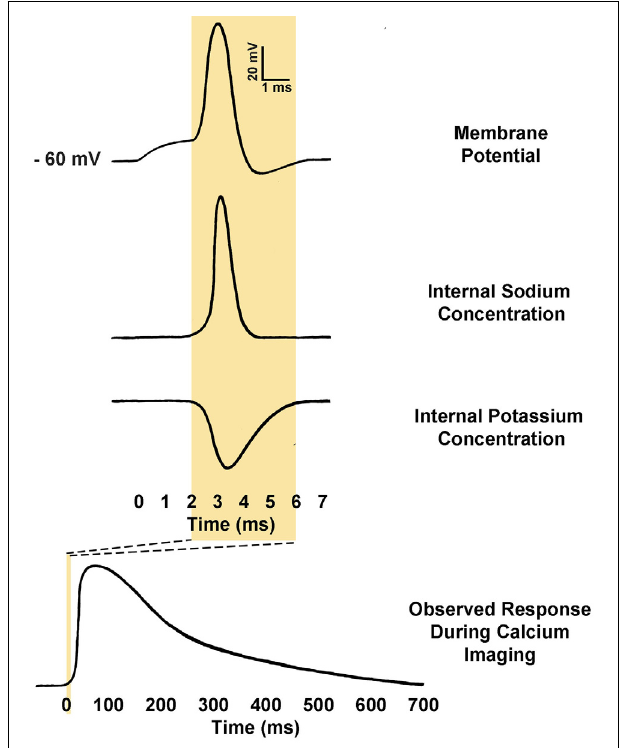
FIGURE 3 | Comparison of action potential kinetics and calcium imaging responses. Calcium indicators are used to measure relative calcium concentration, and this is often used as a proxy for action potential firing. Action potentials consist of an initial depolarization to action potential threshold, which opens voltage-gated sodium channels, causing rapid depolarization of membrane potential. The membrane potential is then rapidly repolarized by the opening of voltage-gated potassium channels. As a result, a typical action potential may only last from 2 to 5 ms. Conversely, observed calcium responses within the somatic cytosol of neurons during action potential firing may require anywhere from 500 to 1000 ms to return to baseline fluorescence (Rahmati et al., 2016). The kinetics of the response is determined in part by the calcium buffering of the neuron itself as well as the affinity and concentration of the calcium indicator present (Borst and Abarbanel, 2007; Hires et al.,